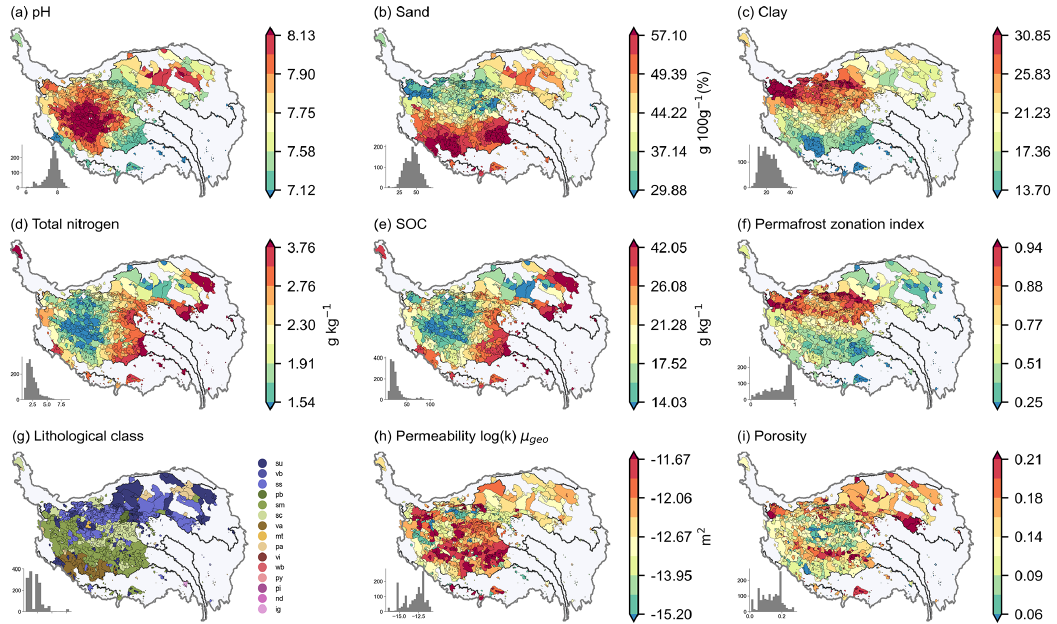
Figure 10. Spatial distribution of soil and geology characteristics for inter-lake catchments on the TP.